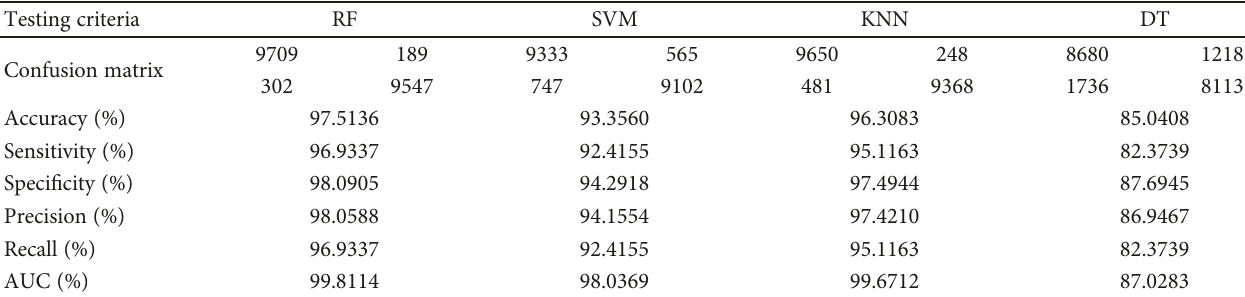
Table 11: Performance measures of the classi fi ers for FSW